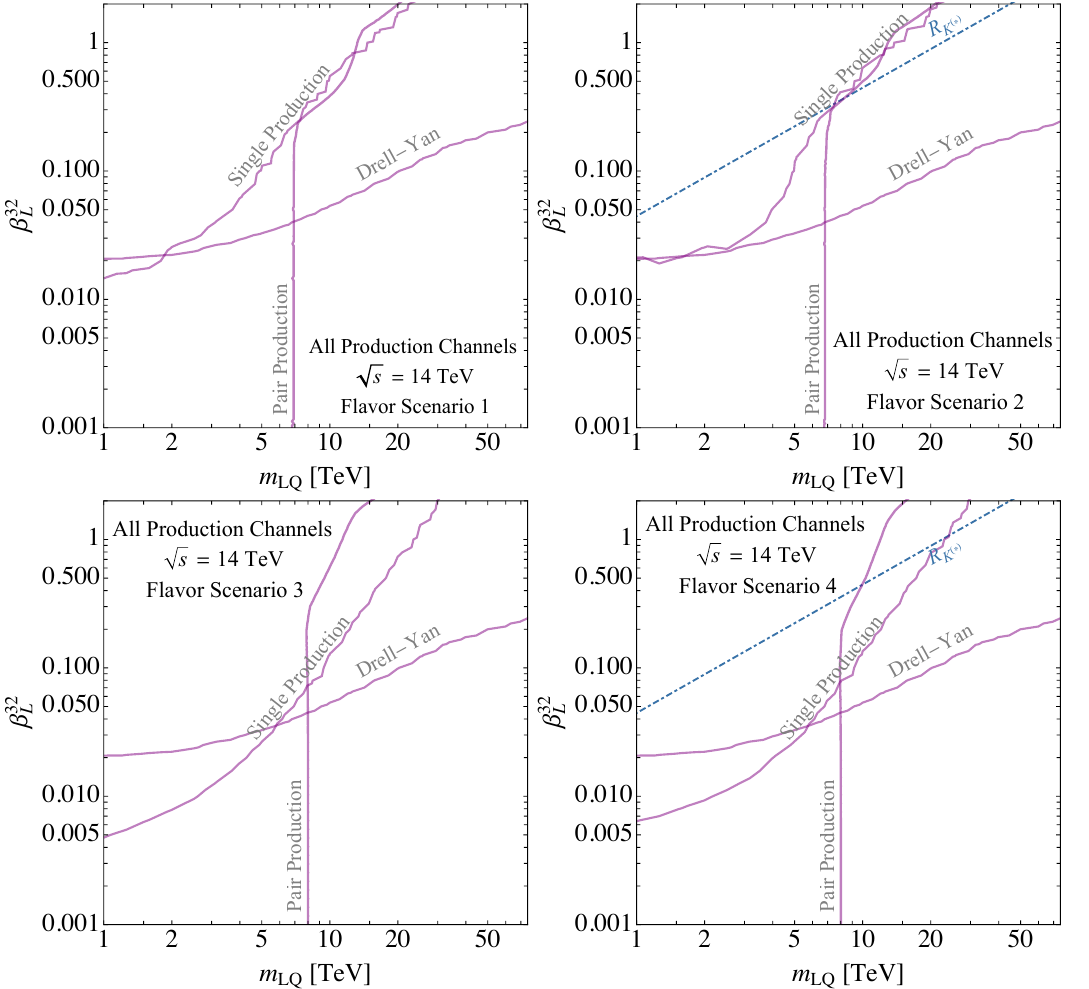
√ Figure 14 . Same as figure 13 but for s = 14 TeV. Any LQ model in the region to the left or above the purple lines can be discovered by their corresponding